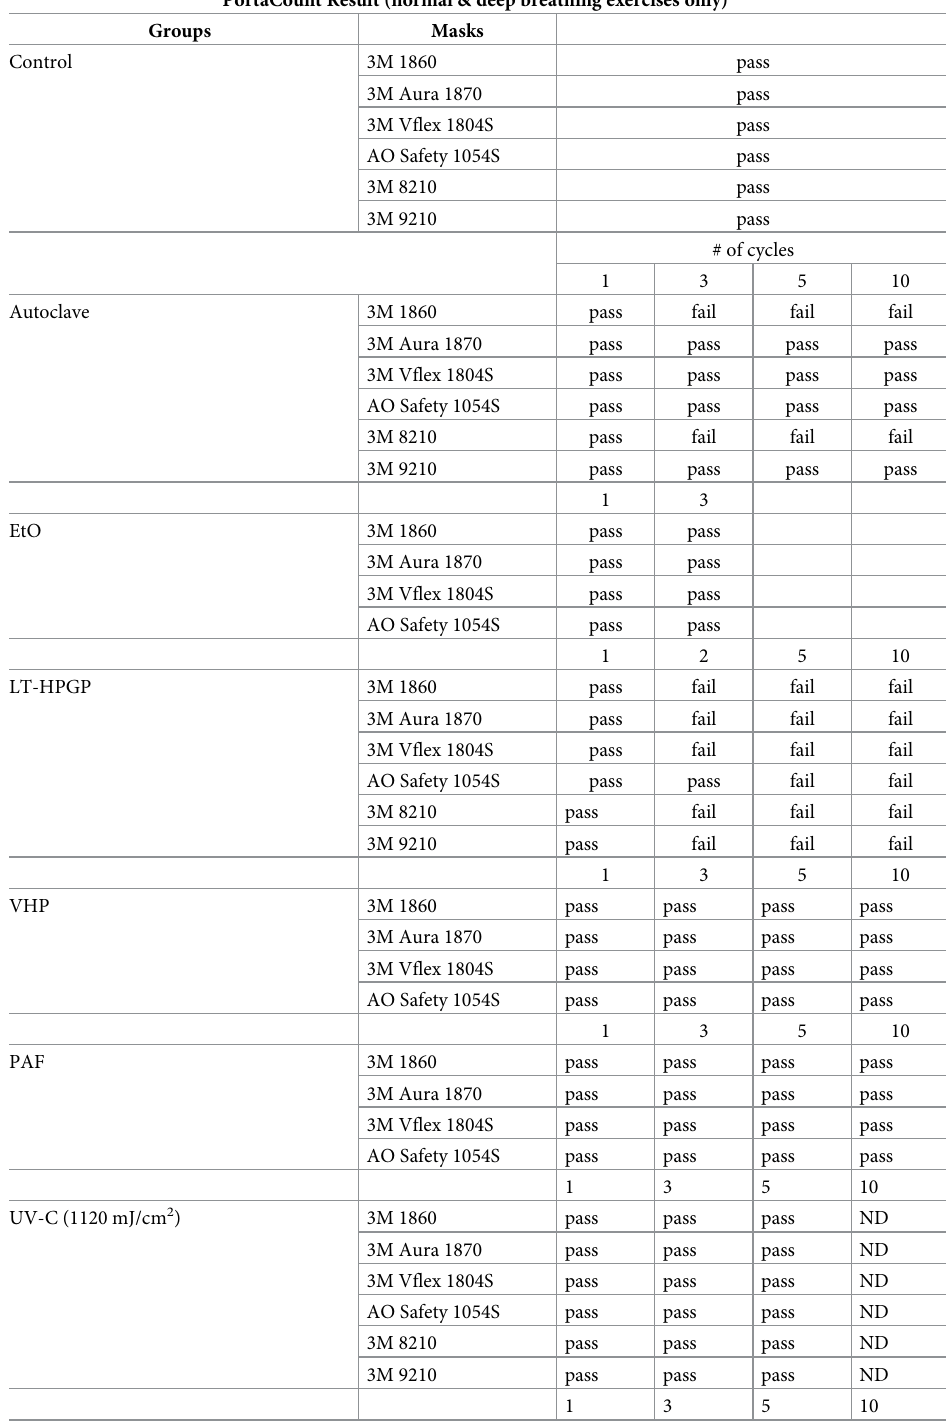
Table 2. Quantitative fit testing results of N95 masks after repeat decontamination